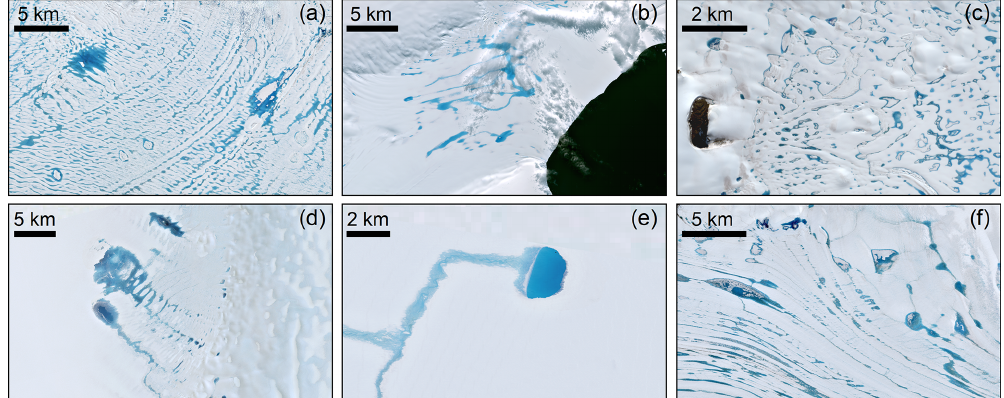
Figure 2. Sentinel-2 optical image extracts (RGB) showing supraglacial lake occurrence on (a) 19 January 2020 over George VI Ice Shelf, (b) 29 January 2020 over Bach Ice Shelf, (c) 23 January 2021 over Wilkins Ice Shelf, (d) 2 February 2017 over Riiser-Larsen Ice Shelf, (e) 21 January 2019 over Nivlisen Ice Shelf and (f) 2 January 2019 over Amery Ice Shelf. Data source: Copernicus Sentinel-2 data.